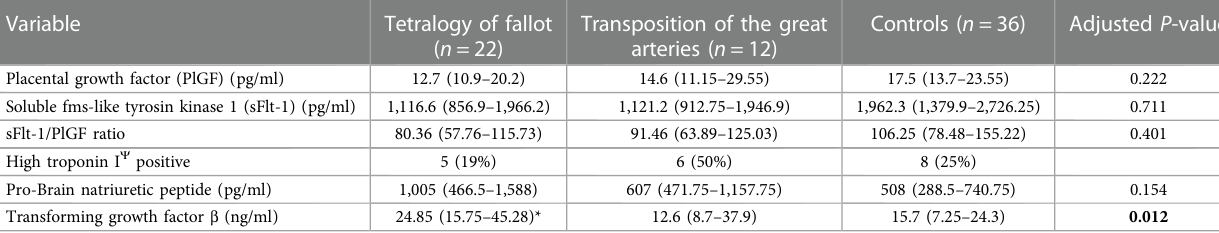
TABLE 3 Concentrations of biomarkers in cord blood the study populations.